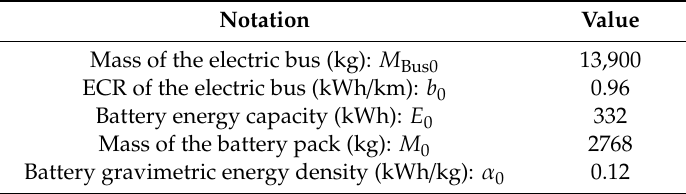
Table 1. The parameters of the plug-in charged electric bus.